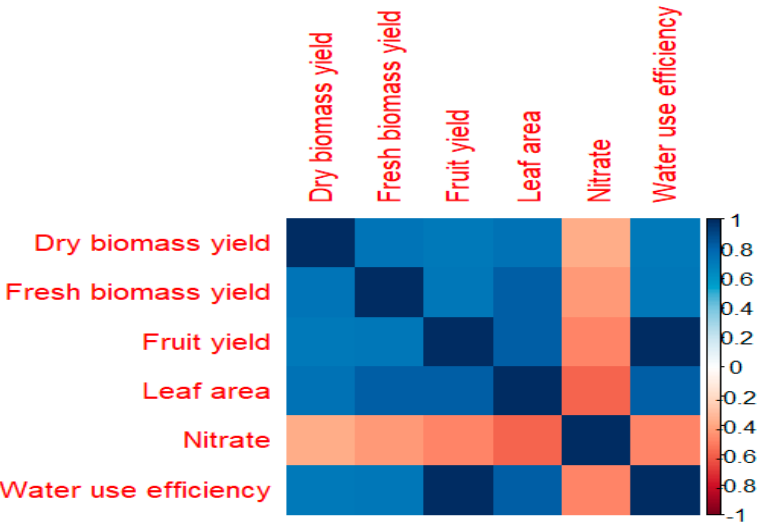
Figure 5. Correlation heatmap of measured plant parameters in 2020 planting season. The blue color on the correlation map signifies positive correlation, the red color signifies negative correlation and the correlation coefficient (R) is as indicated on the − 1 to +1 color scale on the right side of the correlation heatmap.